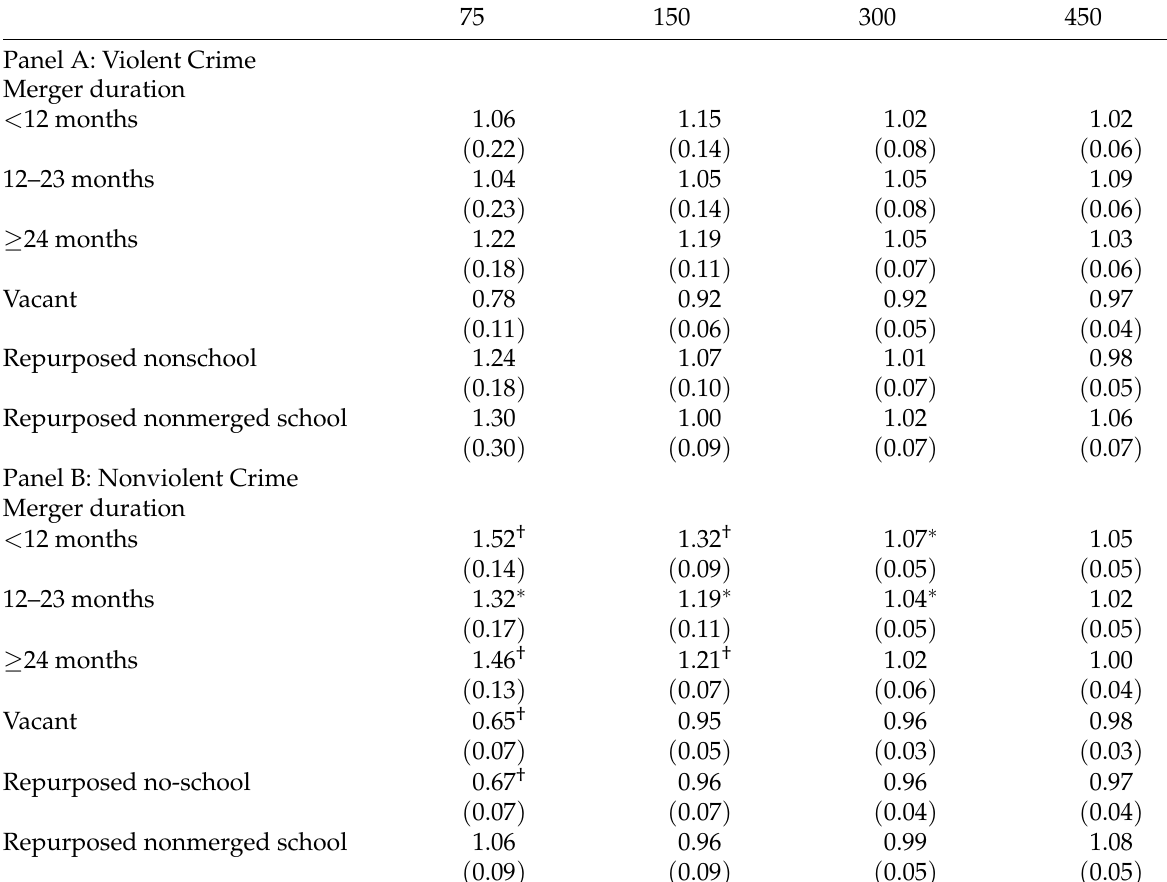
Table 5: Results from negative binomial regressions of violent and nonviolent crime counts on school closure condition by buffer radius and merger